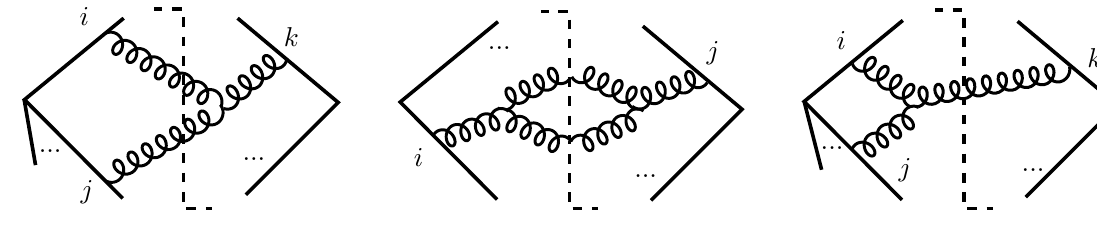
Figure 7 . Sample two-loop diagrams included in eqs. (3.12) and